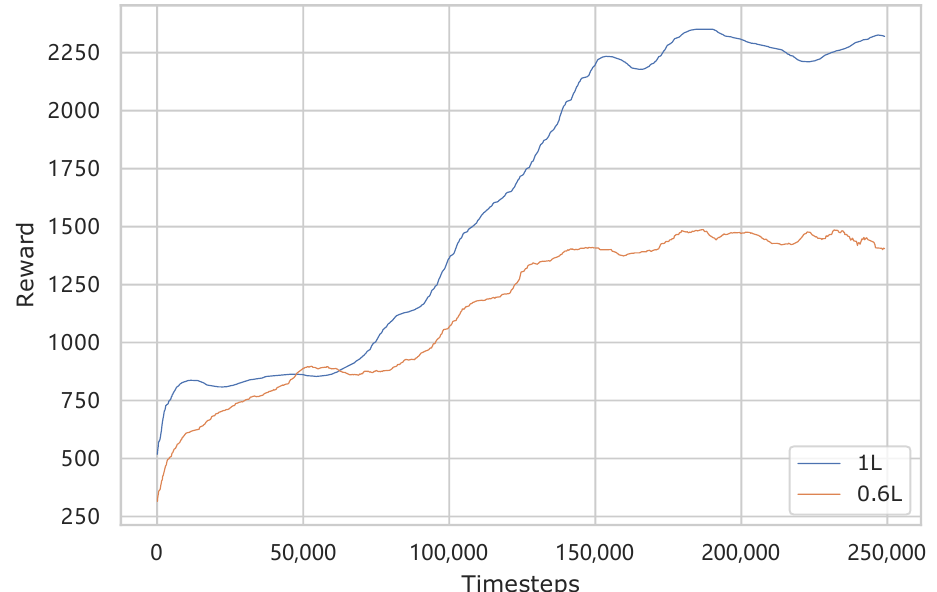
Figure 3. Reward on each time step on a 1 L (23 cm) and 0.6 L (13.8 cm) leg length simulation. The training process shows that longer legs reach higher rewards in the later learning